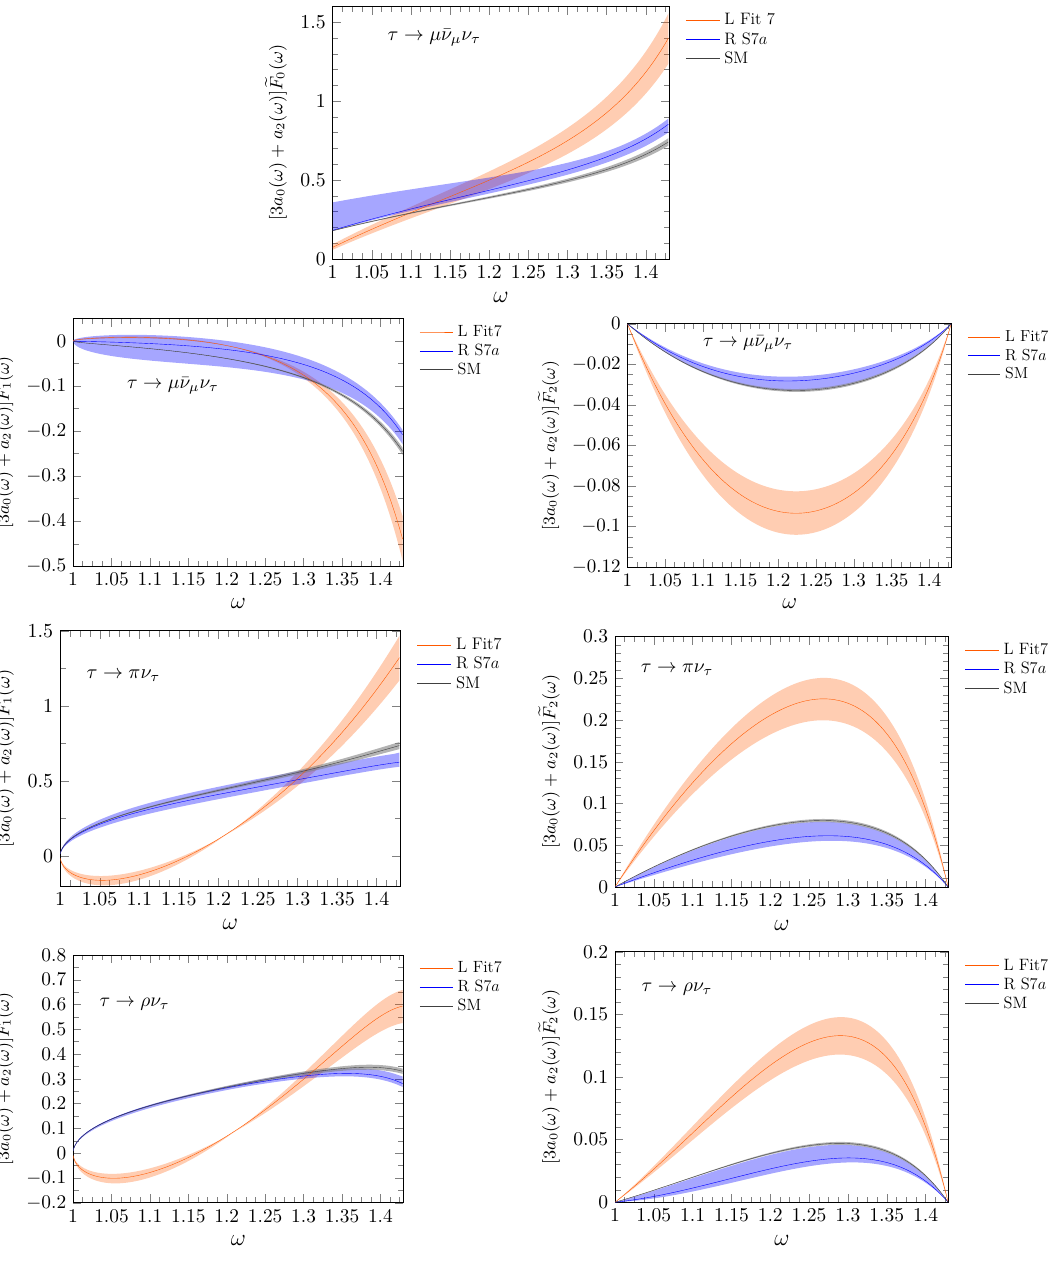
Figure 7 . Results for the functions n 0 ( ω ) e F d ( ω ) evaluated for the ¯ B → Dτ ( µ ¯ ν µ ν τ , πν τ , ρν τ )¯ ν τ 0 , 1 , 2 decays, keeping y = m µ,π,ρ /m τ finite, and obtained within the SM and the beyond the SM scenarios of Fits 7 and 7a of refs. [42] and [45], which only includes left- (right-)handed neutrino NP operators, respectively. Error bands account for uncertainties induced by both form-factors and fitted Wilson coefficients (added in